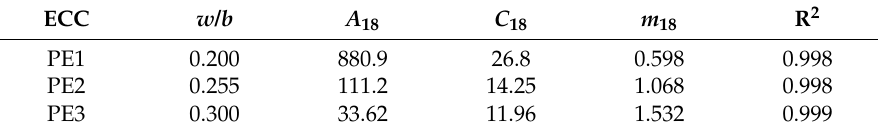
Figure 9. MOR-Conductance correlation using dual frequency for ( a ) PE1 specimen; ( b ) PE2 specimen; ( c ) PE3 specimen. Table 9. Regression coefficients at f = 1.8 GHz and goodness of fits for Equation (5).